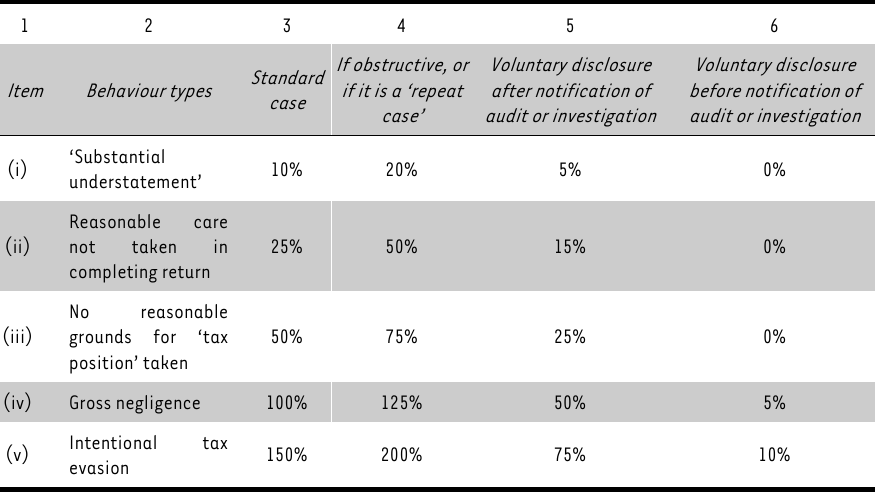
Understatement penalty percentage (section 223 of the